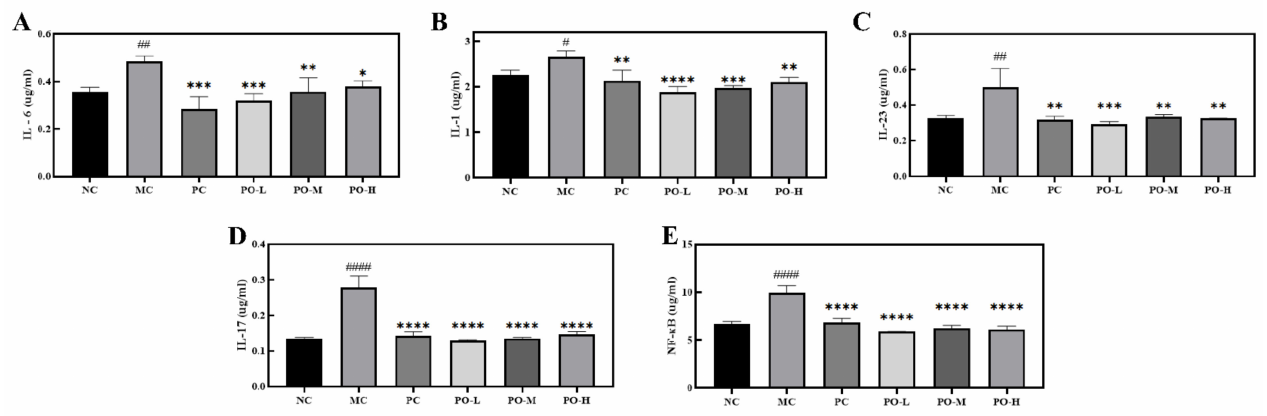
Figure 4. The inhibitory effect of PO on the expression level of inflammation-related factors and the nuclear factor kappa-B. (A) The expression level of IL-6 in the serum. ( B ) The expression level of IL-1 in serum. ( C ) The expression level of IL-23 in the serum. ( D ) The expression level of IL-17 in the serum. ( E ) The expression level of NF- κ B in serum. IL-6, IL-1, IL-23, IL-17, and NF- κ B in serum of BABL/c mice were determined with Elisa kits. Data are shown as mean ± SEM (n = 8), # p < 0.05, ## p < 0.01, #### p < 0.0001 vs. NC group, * p < 0.05, ** p < 0.01, *** p < 0.001, **** p < 0.0001 vs. MC